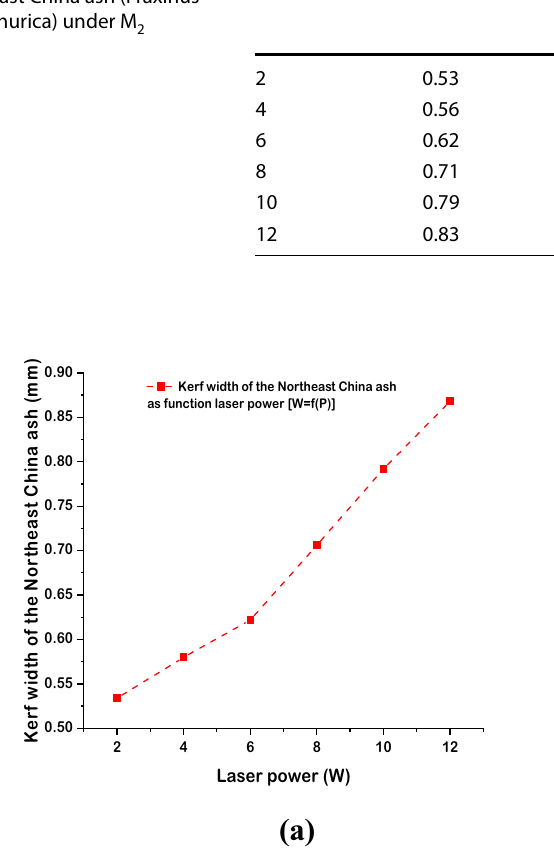
Table 6 Kerf width data of Northeast China ash (Fraxinus mandshurica) under M